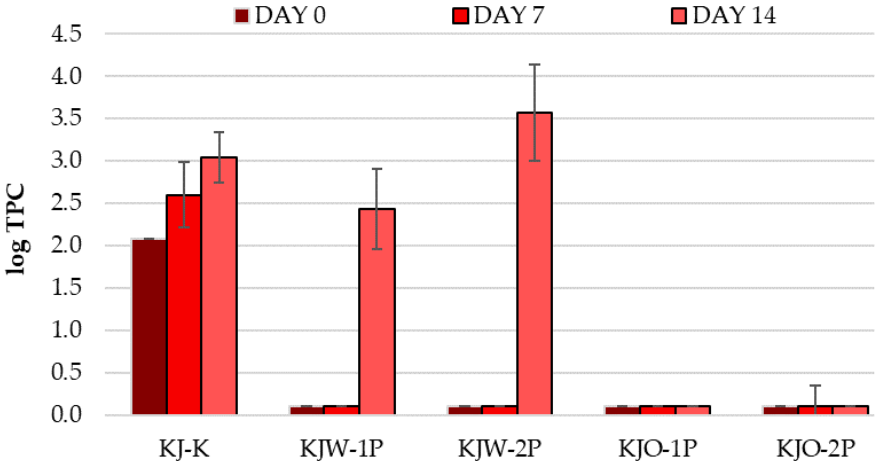
Figure 7. Change in total plate count (TPC) during the storage of control and MAP ‘Kántorjánosi’ sour cherries with different washing pretreatments.